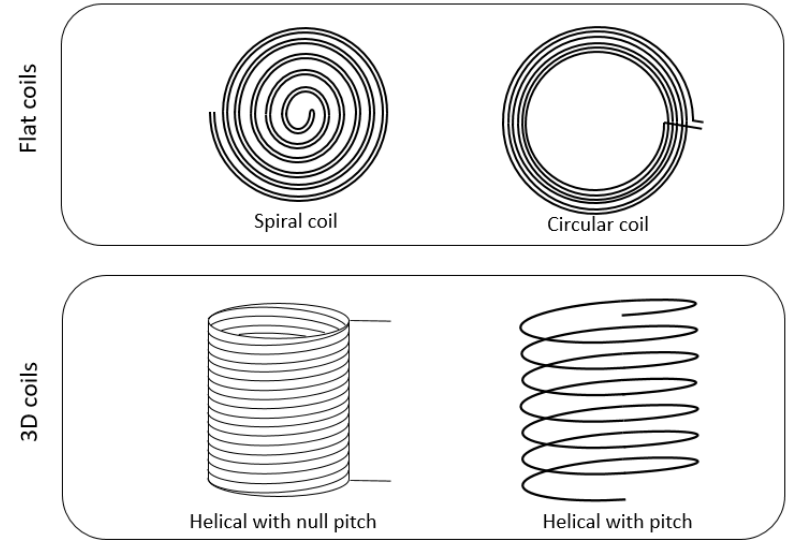
Figure 9. Topology of coils in SCMR systems.